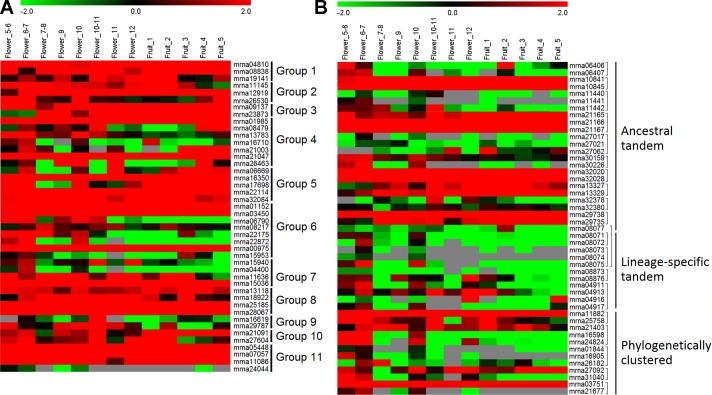
Expression profiles of FveERF genes in different stages of Fragaria vesca flowers and early-stage fruits. (A and B) The mRNA levels of the non-tandem (A) and tandem/phylogenetically clustered (B)
FveERF genes. Genes located in the same tandem repeat or in a phylogenetic cluster are grouped together. Mrna08077 forms an ancestral tandem repeat with mrna08071–mrna08075. Mrna21403 forms a phylogenetic cluster with mrna29735. Data were retrieved from http://bioinformatics.towson.edu/strawberry/ (Hollender et al., 2012; Darwish et al., 2013; Kang et al., 2013). Expression levels were calculated in the log2 scale. For a detailed description of the stages, please see http://bioinformatics.towson.edu/strawberry/newpage/Tissue_Description.aspx.